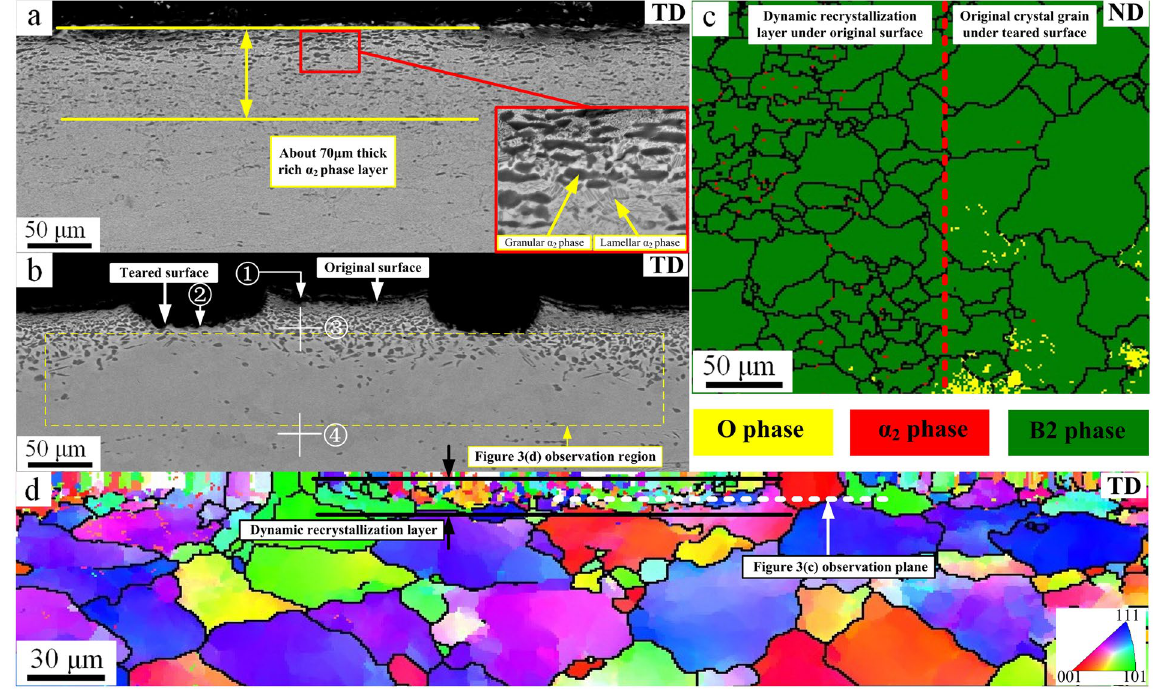
Figure 3. Stretching microstructure; ( a ) TD surface via BSEM prior to stretching; ( b ) TD surface via BSEM after stretching; ( c ) ND surface dynamic recrystallization layer; ( d ) EBSD orientation distribution of the yellow region in ( b